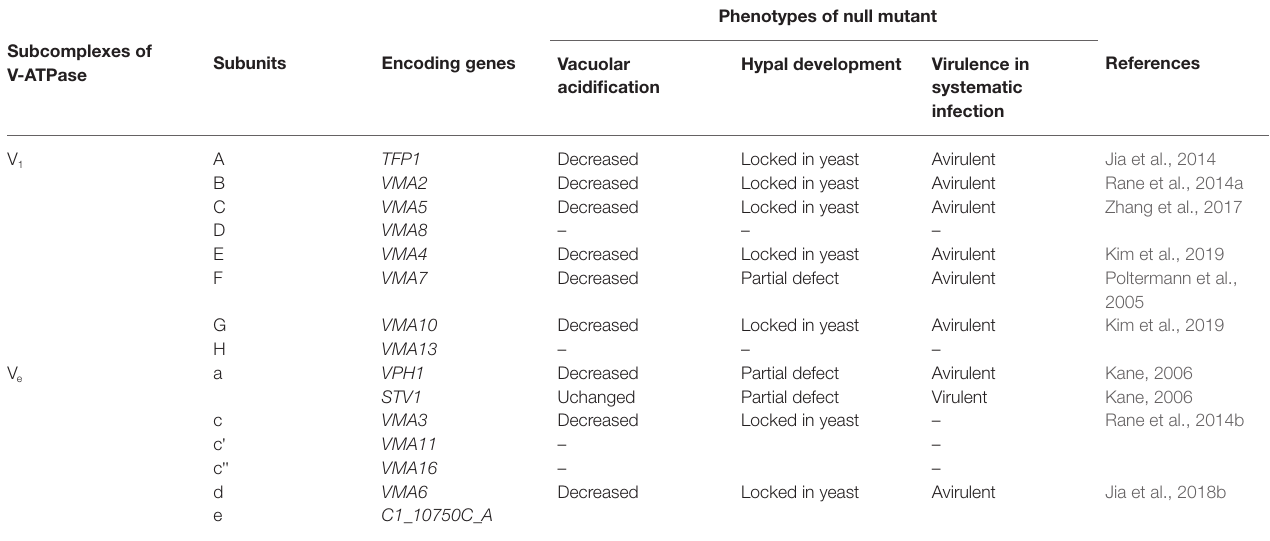
TABLE 1 | Genes encoding the subunits of V-ATPases and their null mutant phenotypes in C. albicans .